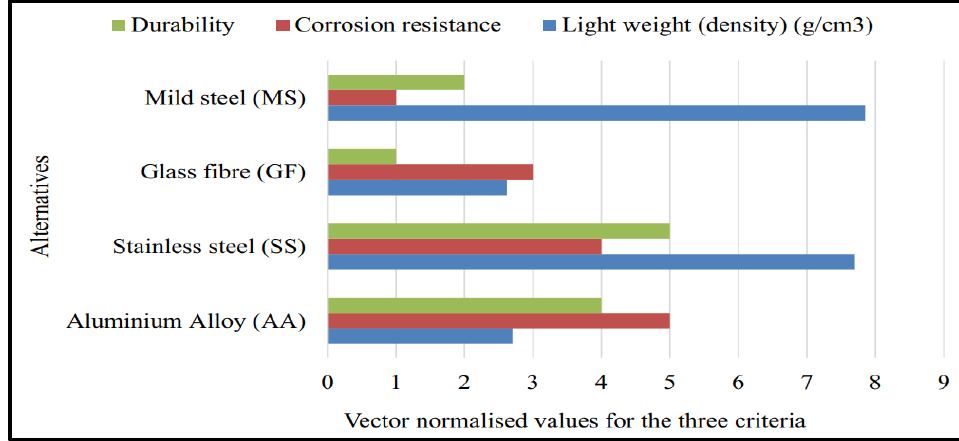
Figure 3. The analysis of the alternatives with the normalized vector values.